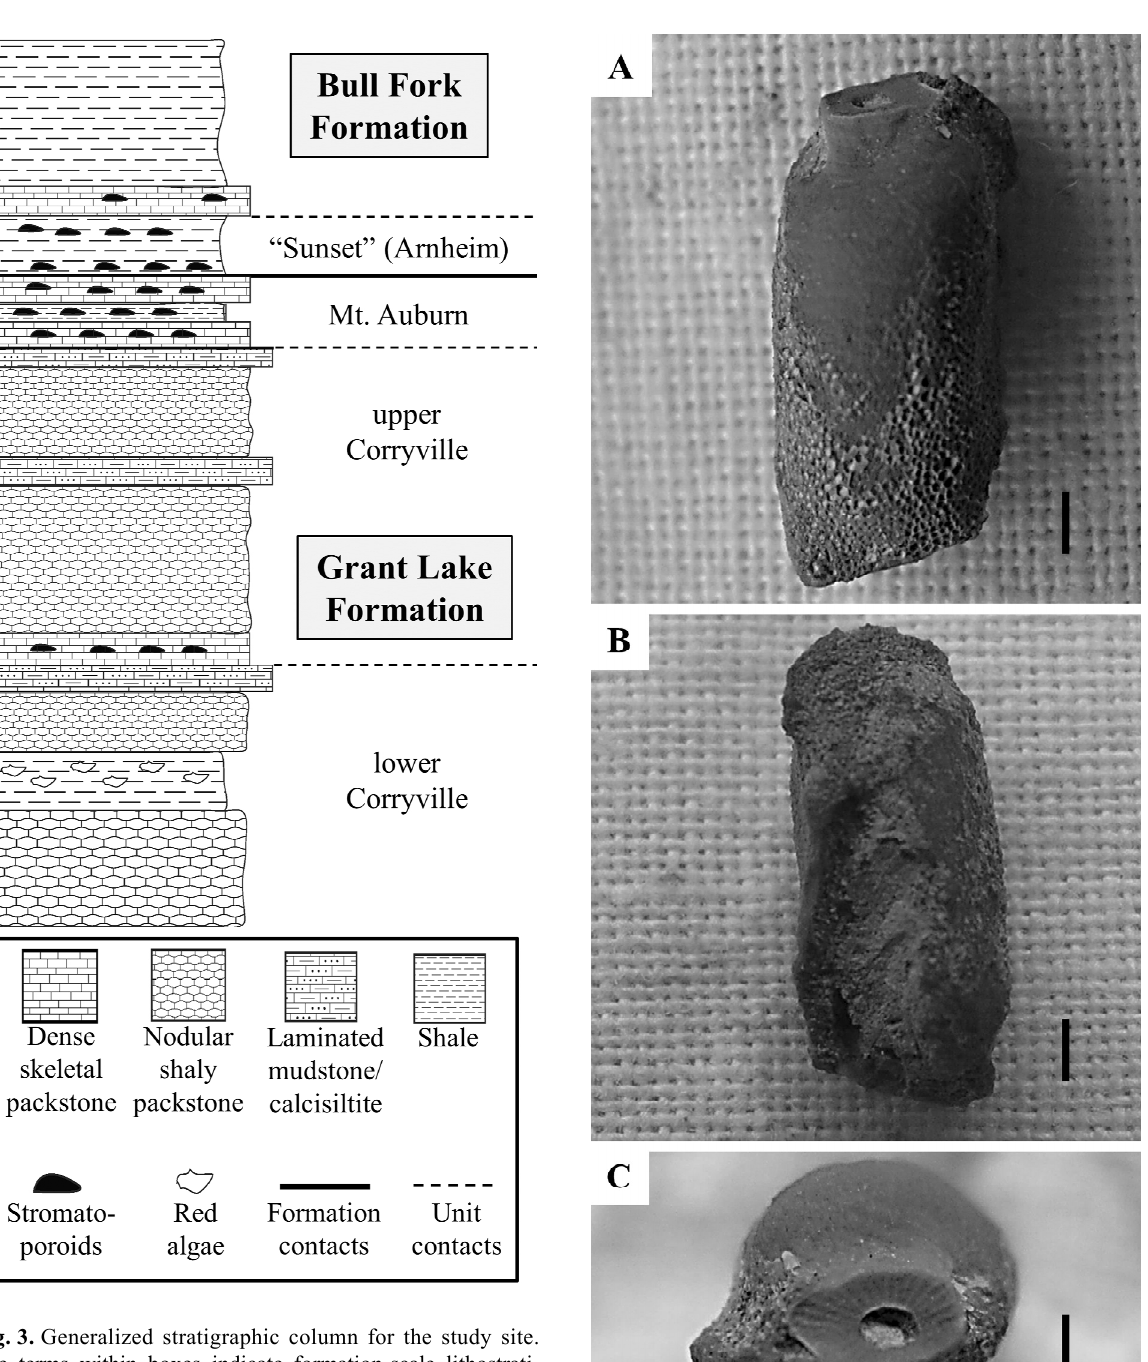
Fig. 3. Generalized stratigraphic column for the study site. The terms within boxes indicate formation-scale lithostrati- graphy for northern Kentucky and other terms represent finer stratigraphic subdivisions that correspond to the lithostrati- graphic nomenclature of southern Ohio. The (cid:147)Sunset Shale(cid:148) is treated as the basal unit of the Bull Fork Formation, which correlates to the basal interval of the Arnheim Formation of Ohio terminology. The specimen described herein almost certainly emanated from the (cid:147)upper Corryville(cid:148) unit within the Grant Lake Formation. Scale bars to the left of the stratigraphic column represent meters.